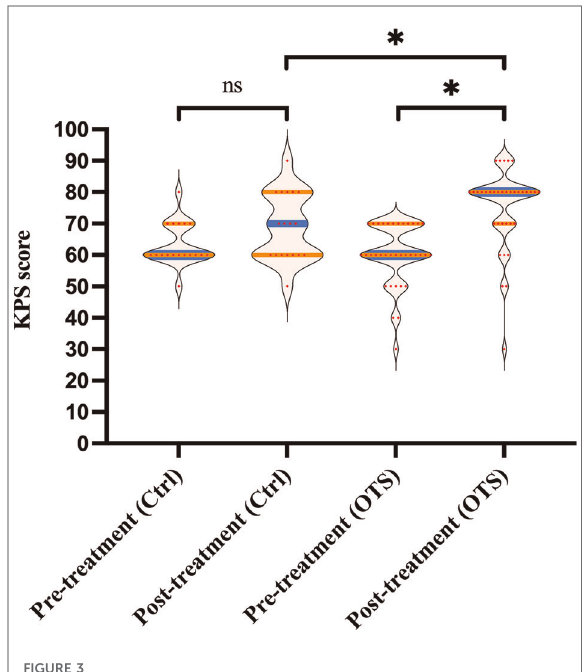
FIGURE 3 The KPS score pre/posttreatment.